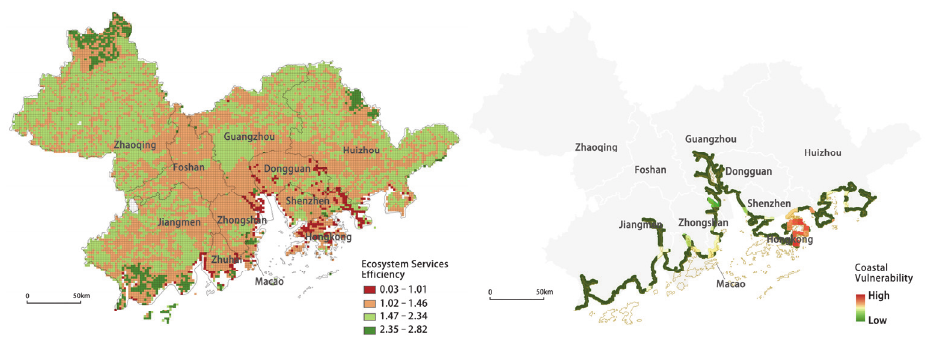
Figure 9. ES efficiency and coastal vulnerability spatial distribution.